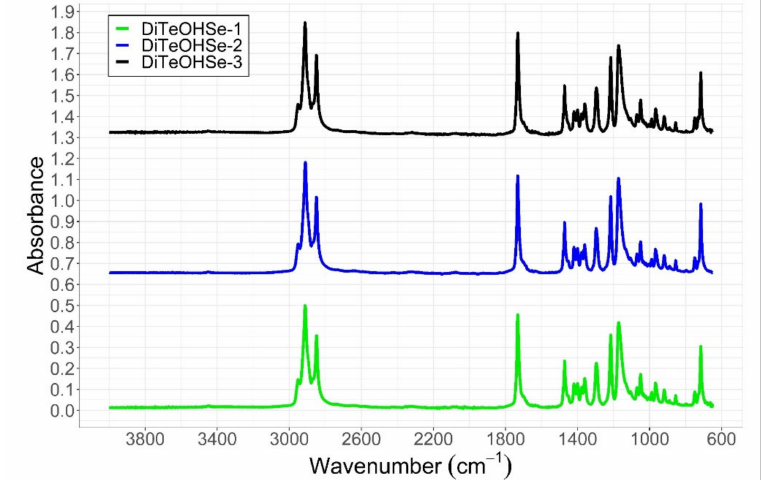
Figure A3. IR spectra of the three repetitions of DiTeOHSe synthesized to validate the synthesis procedure. No residual acid or alcohol is visible in the ranges between 3600–3100 cm − 1 (O–H stretching from alcohols), 3300–3000 cm − 1 and 3000–2100 cm − 1 (O–H stretching from carboxylic acids), or at 1705 cm − 1 (C–O stretching from carboxylic acids).Therefore, the synthesis was considered